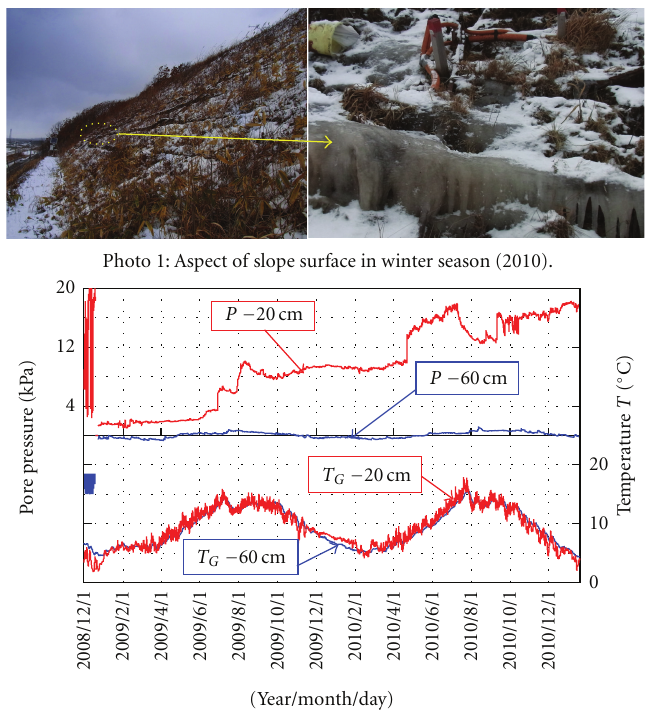
Figure 9: Relationship between pore pressures and temperatures in the